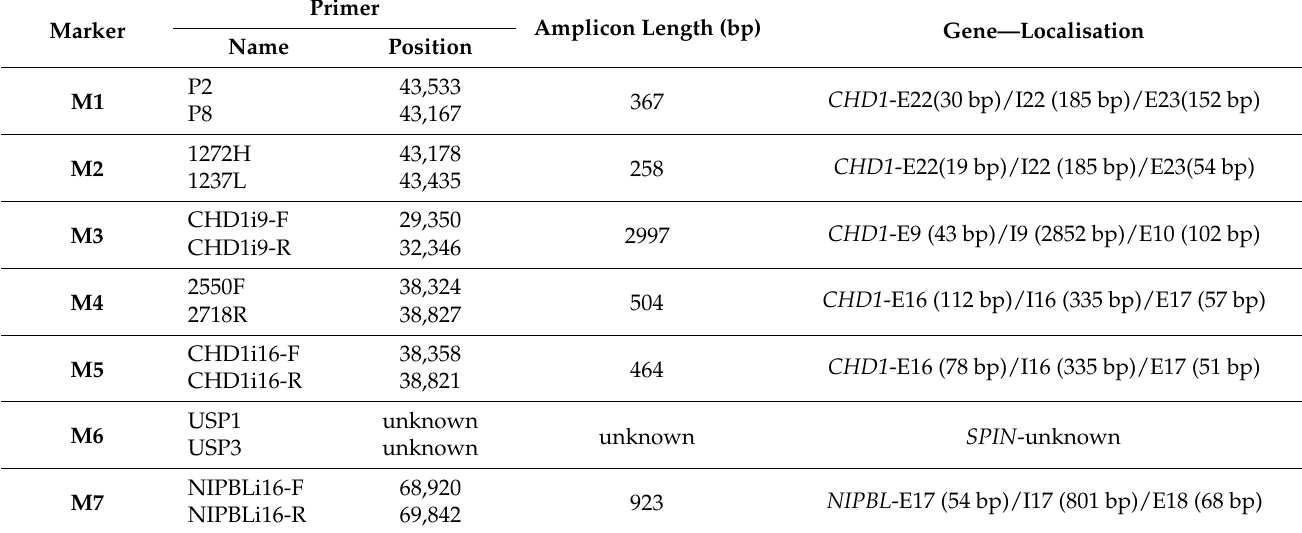
Table 3. Components of M1–M7 amplicons predicted based on the location of the appropriate primer pairs within the CHD1 , SPIN , and NIPBL genes. The lengths of the amplified exon (E) and intron (I) fragments are given in